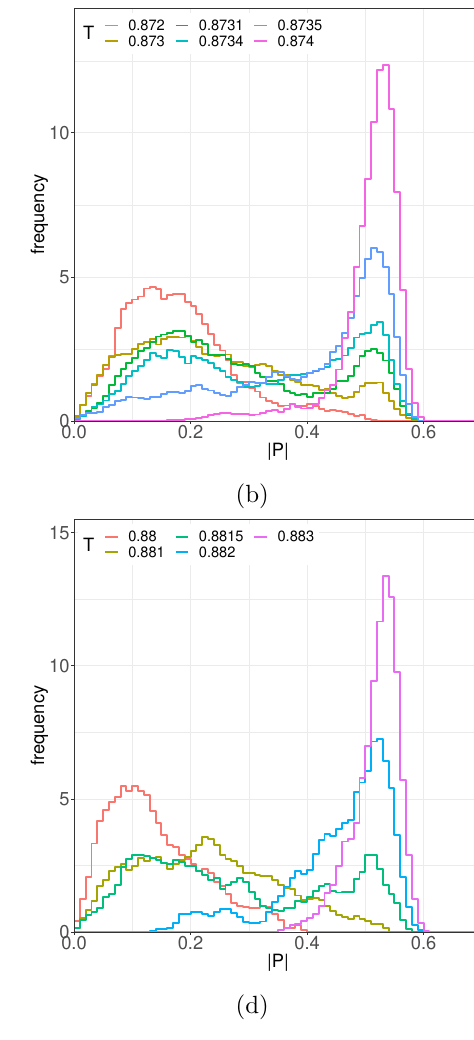
Figure 10. Histograms of j P j for D = 26: a) N = 48, L = 48, b-d) N = 64, L = 24 ; 32 ;